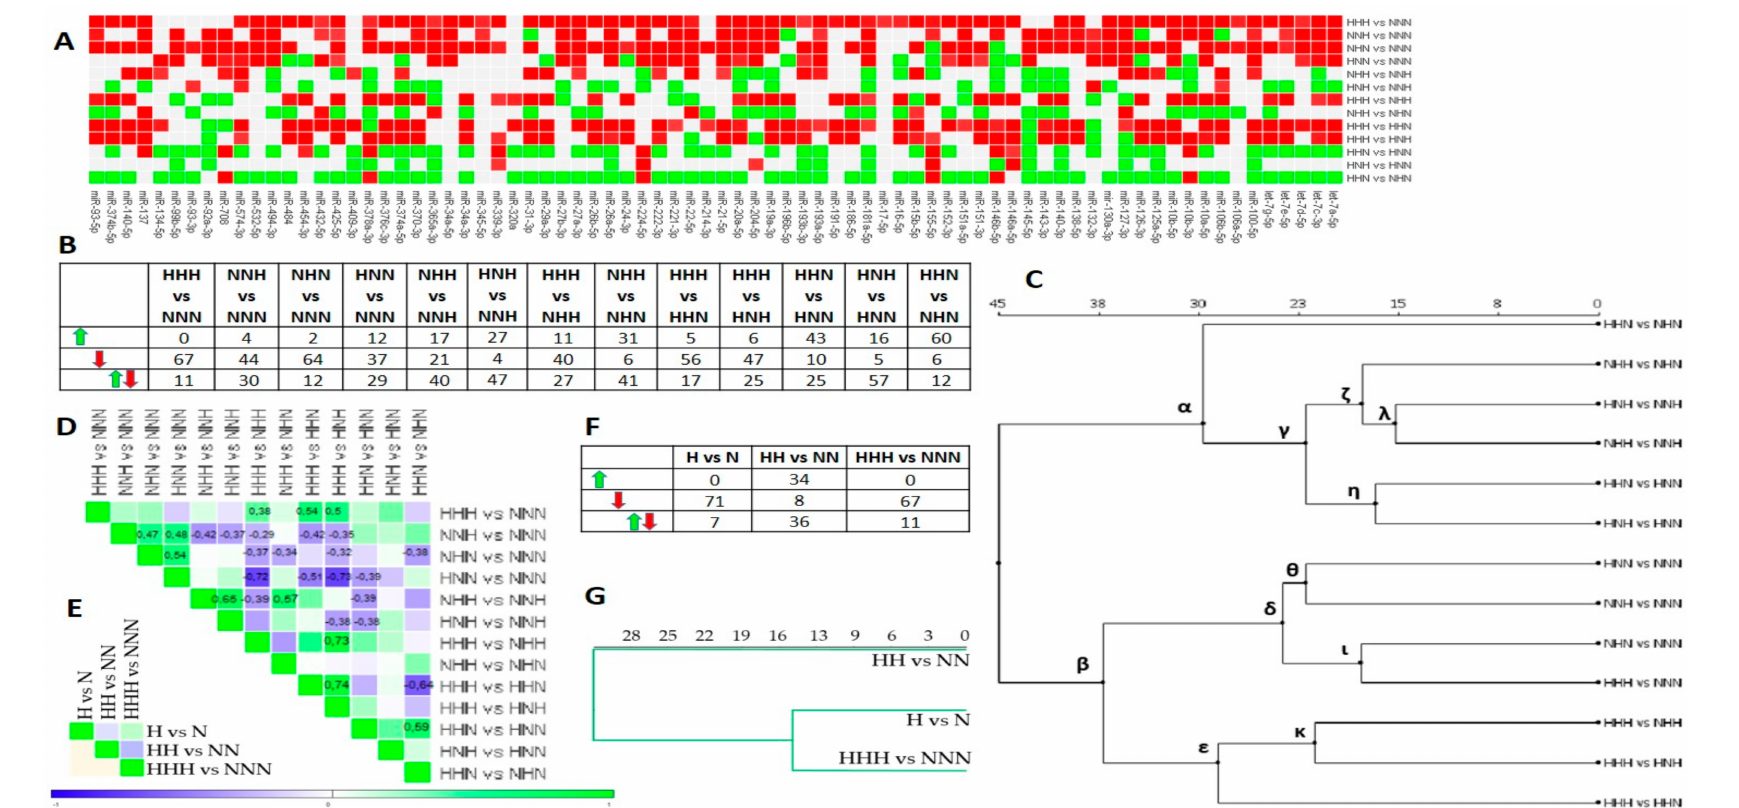
Figure 4. miRNAs expression changes triggered by chronic and intermittent HG in mature Ads, based on FC values. ( A ) The heat map diagram shows the expression changes of the examined miRNAs in mature Ads exposed to chronic and intermittent HG. Red denotes an expression decline (FC < − 1.5), green indicates an expression increase (FC > 1.5), and grey shows no changes. ( B ) Table depicts a numerical summary of the miRNAs changes from the heat map in ( A ). ( C ) Euclidean hierarchical clustering of studied comparisons. ( D ). Heat map shows positive (green) and negative (blue) Pearson’s correlation coefficients for pairwise comparisons of variants of mature Ads exposed to chronic or intermittent HG stimulation. ( E ) Heat map presents positive (green) and negative (blue) Pearson’s correlation coefficients for pairwise comparisons of variants of pAds, as well as differentiated and mature Ads exposed to chronic HG. ( F ) Table displays a numerical summary of miRNAs changes from the heat map in ( E ). ( G ) Euclidean hierarchical clustering of comparisons from ( E